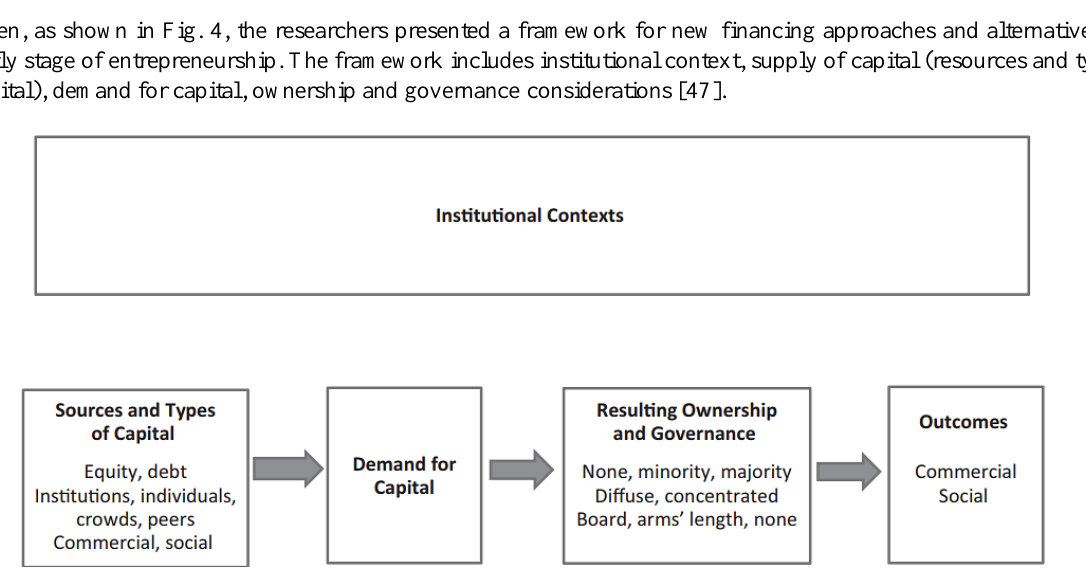
Figure 4. The framework for new financing approaches and alternatives at the early stage of entrepreneurship [47] Mollick (2014), Agrawal et al. (2015) and Yu et al. (2017) have found that, despite the fact that the effect